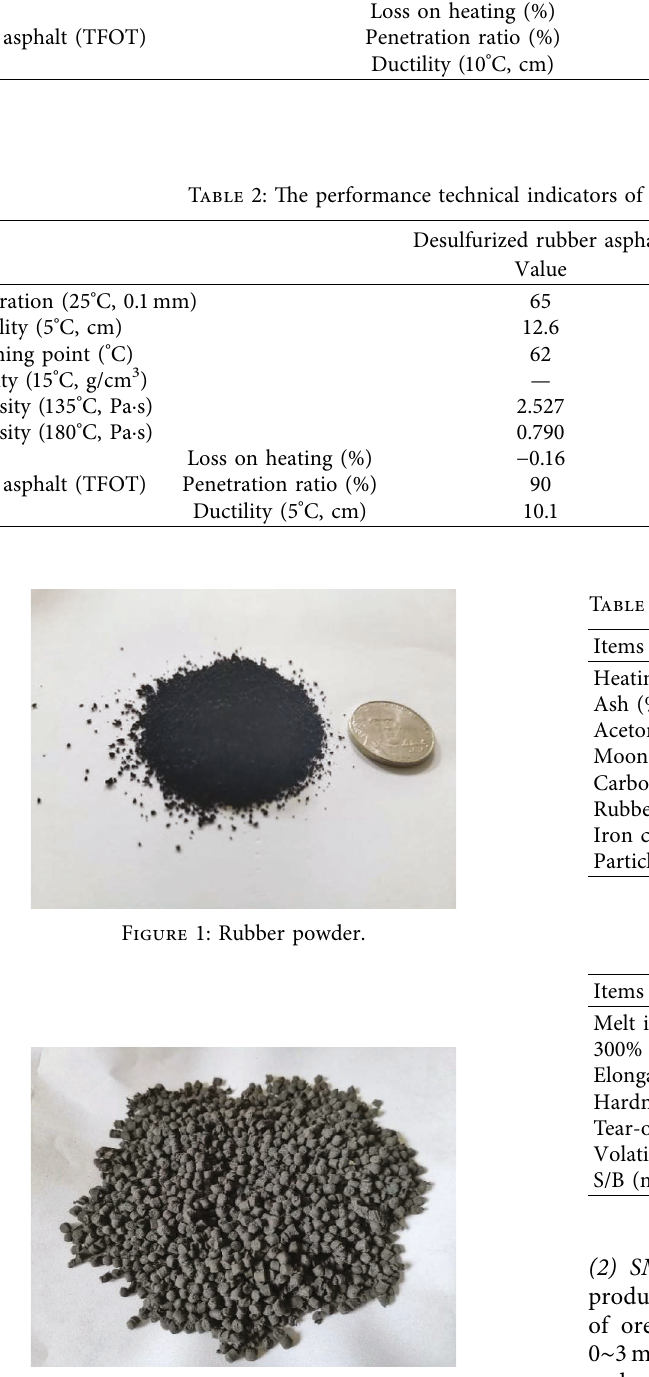
Figure 2: Desulfurized rubber powder.